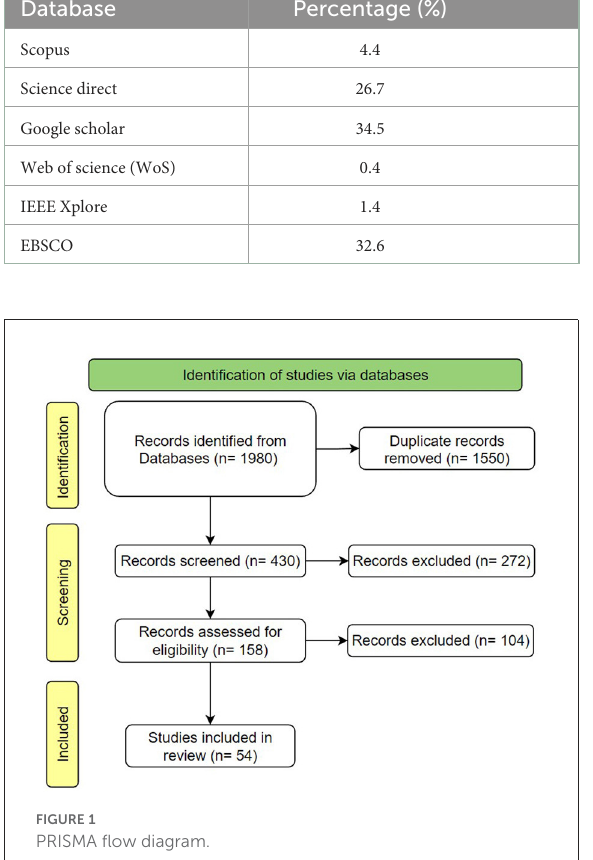
FIGURE1 PRISMA flow